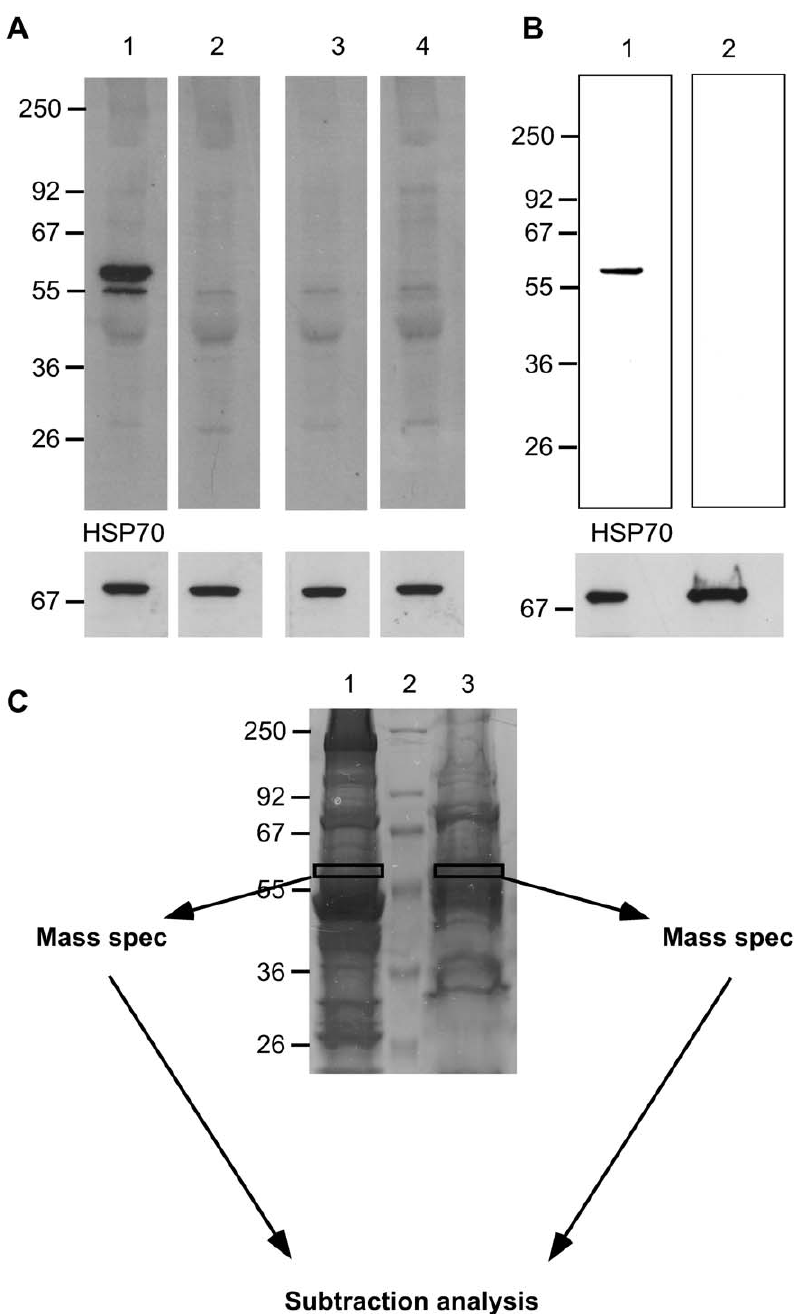
Figure 4. Autoantigen isolation and identification strategy. Recombinant IgG derived from an IBM muscle plasma cell was used to isolate an unidentified target antigen. Muscle tissue homogenates (25 m g) were resolved by SDS-PAGE, then stained with coomassie brilliant blue or transferred to nitrocellulose. Molecular weight markers (kDa) are indicated on the left of all panels. An immunoblot (A) of muscle tissue homogenate probed with rIgG derived from a single IBM-tissue associated plasma cell (rIgG-5) demonstrated binding to a candidate antigen (lane 1). Binding was not present with the rIgG-2 (lane 2), derived from a different muscle specimen or with control antibodies, D3a (lane 3) and 18/2 (lane 4) that were derived from a healthy donor and from a patient with lupus respectively. A second immunoblot (bottom) probed with anti-HSP70 served as a loading control. (B) Two separate human skeletal muscle homogenates prepared using either stringent (lane 1) or mild protein extraction conditions (lane 2) were resolved by SDS-PAGE gel, and then transferred to nitrocellulose. Immunoblotting with rIgG-5 (lane 1), demonstrated the target antigen was present when the homogenate was prepared with the stringent extraction, but not with the mild conditions (lane 2). An immunoblot (bottom) with HSP70 served as a loading control. (C) To isolate the candidate antigen, the two homogenates were separated by SDS-PAGE , then bands with the approximate molecular weight of the candidate antigen were excised from the gel. Lane 1, muscle homogenized with the stringent extraction procedure; Lane 2, molecular weight markers; Lane 3, muscle homogenized with the mild extraction procedure. These excised proteins were digested with trypsin and the resulting peptides separated by reverse-phase chromatography, then applied to a mass spectrometer. Proteins present in lane 3 were subtracted from those identified in lane 1 to reduce the complexity of the mass spectrometry data set.